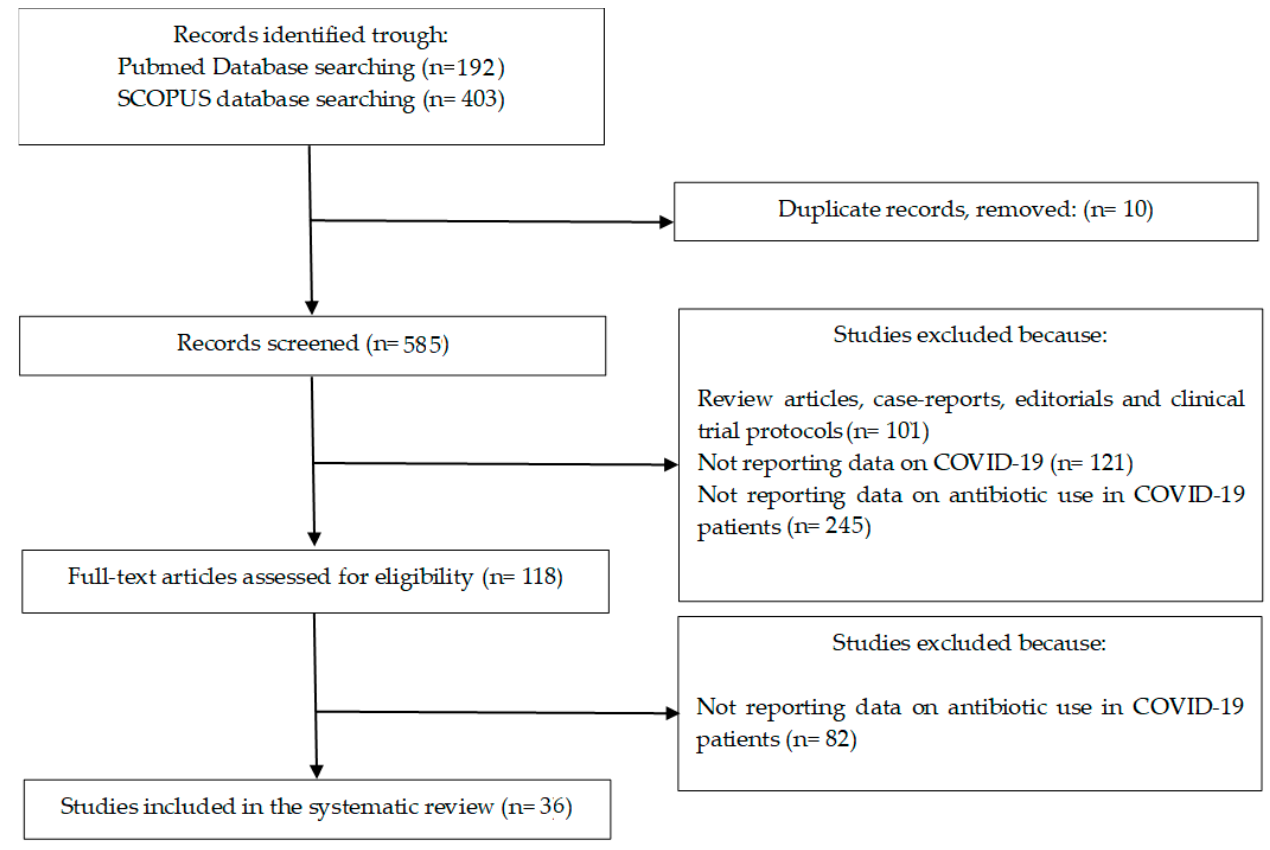
Figure 1. Flowchart depicting the selection process of studies included in the systematic review.